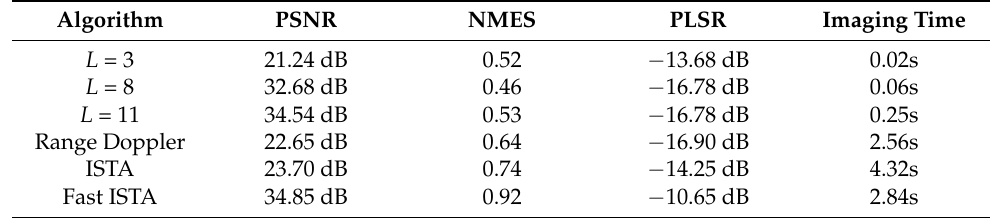
Table 2. Comparison of imaging quality and imaging